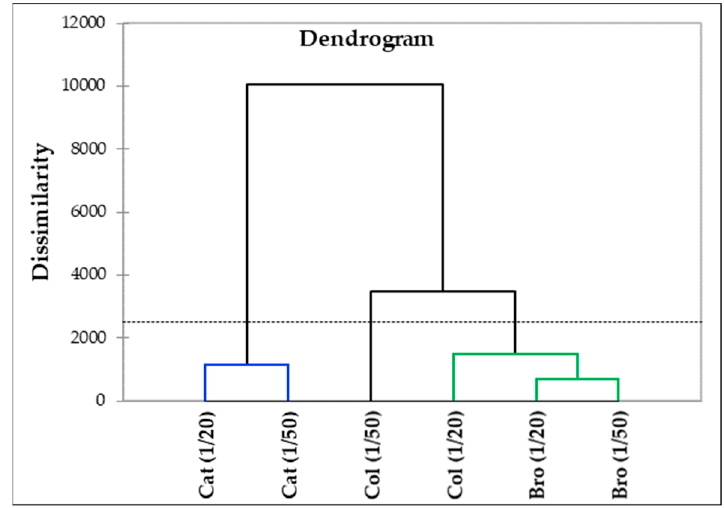
Figure 9. Agglomerative hierarchical clustering (AHC) of hydrolysates according to the enzyme used and by considering all the variables (Cat = cathepsin B, Col = collagenase B, Bro = bromelain; numbers in brackets are relative to the E:C ratio).